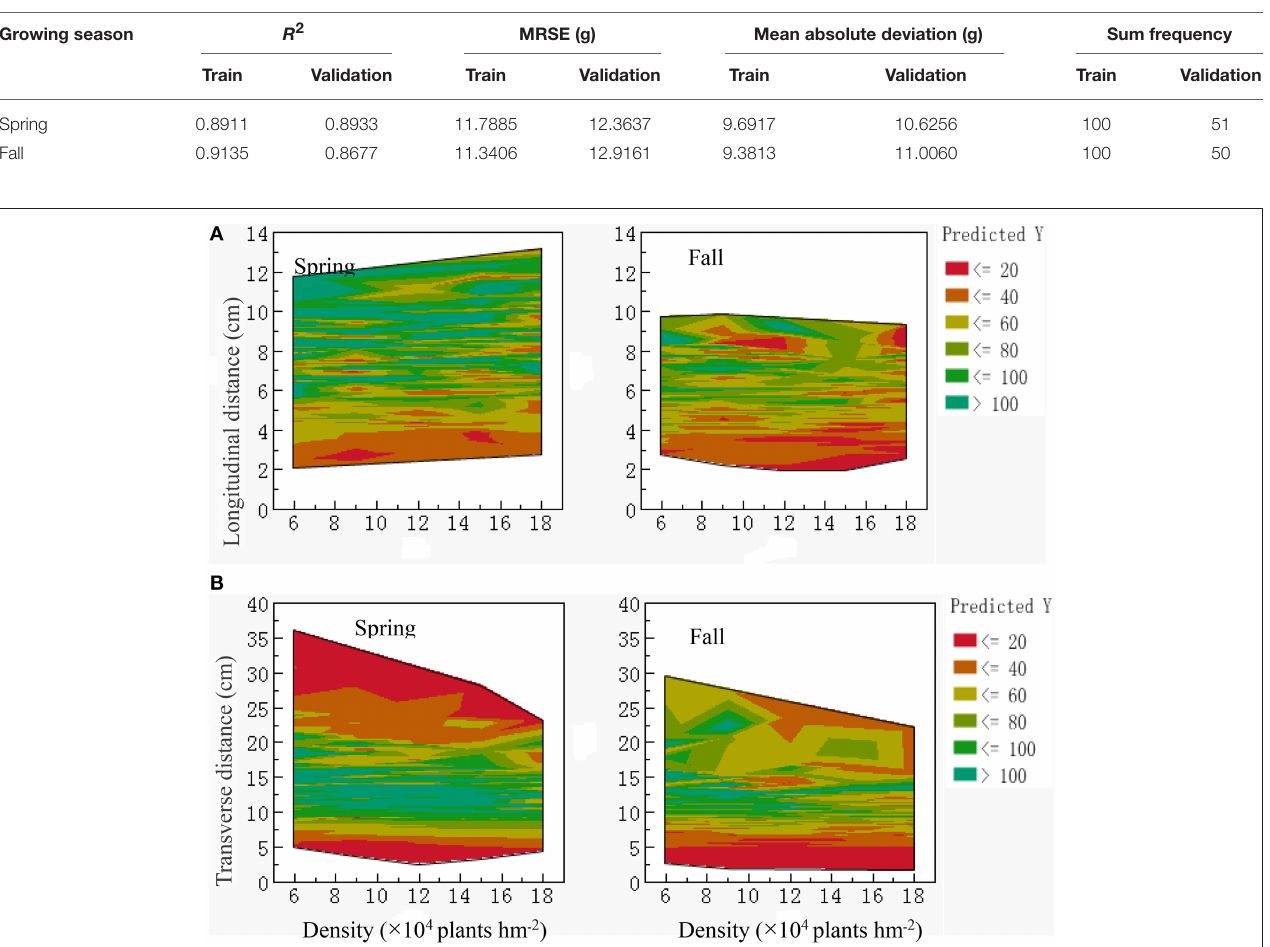
FIGURE 2 | Contour maps of potato tuber weight distribution model predictions under different plant densities. (A) Longitudinal distance (cm); (B) Transverse distance